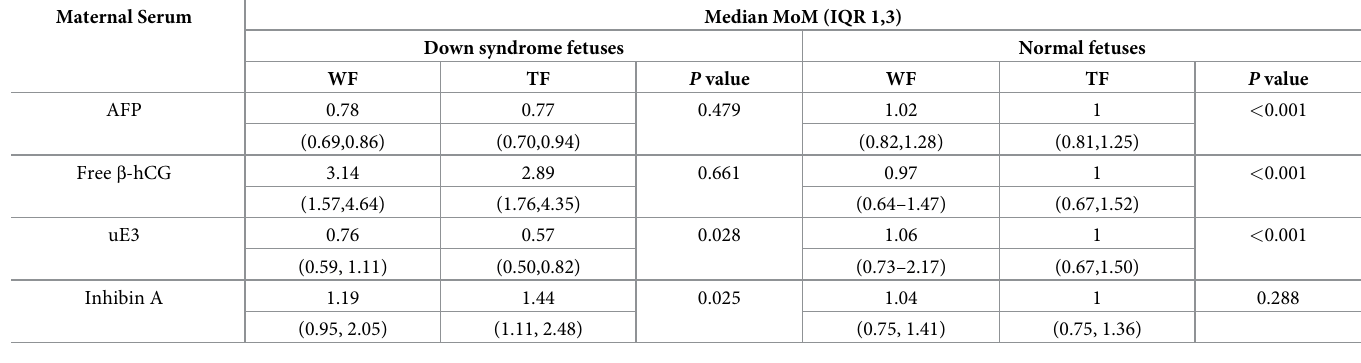
IQR: Interquartile